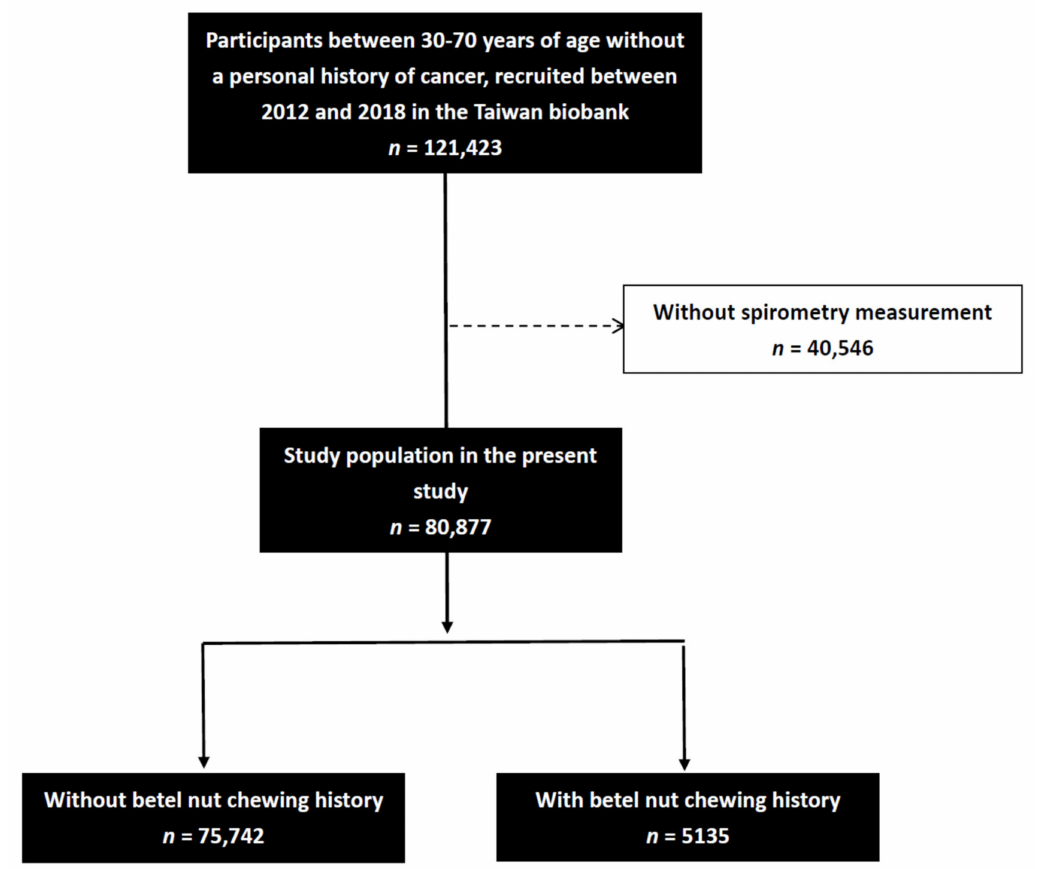
Figure 1. Flowchart of study